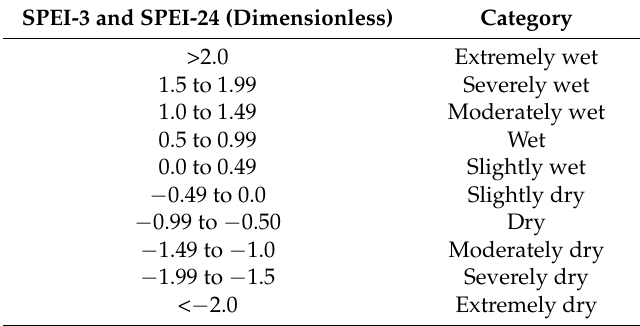
Table 3. Categorization of wet and dry events according to standardized precipitation and evapotranspiration index (SPEI)-3 and SPEI-24 for northern Mexico. Source: M é ndez and Magaña (2009) [31]. SPEI-3 and SPEI-24 (Dimensionless) Category